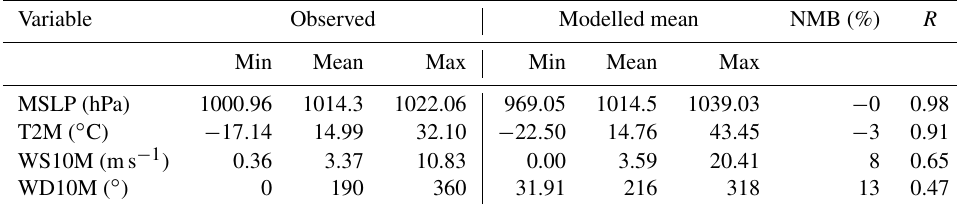
Table 2. Observed mean and simulation summary statistics for meteorological parameters. The normalised mean bias (NMB) and correlation coefficient ( R ) are calculated between simulated and observed meteorological observation from GWO during the April–September 2010